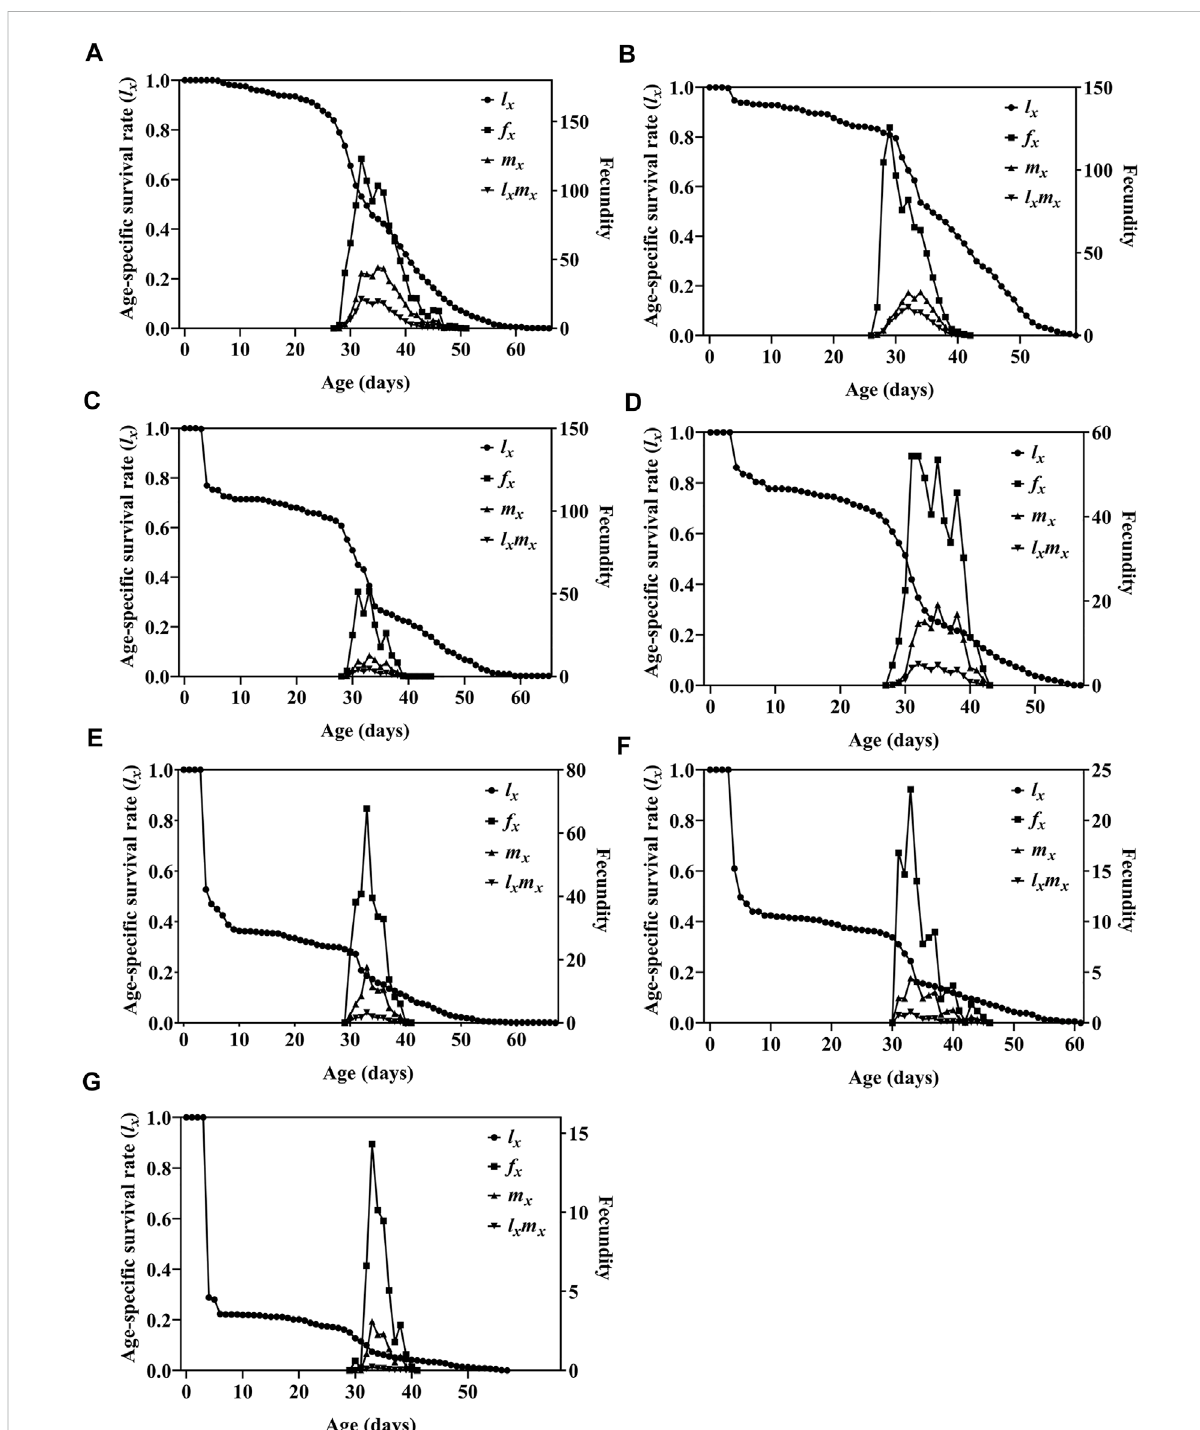
FIGURE 3 Age-speci fi c survival rate ( l x ), age-speci fi c fecundity of female adult ( f x ), age-speci fi c fecundity ( m x ), and age-speci fi c maternity ( l x m x ) of F 1 generation of Spodoptera litura after male parent was irradiated with different doses of X-rays. (A) Survival rate of F 1 generation of nonirradiated parents (N \ × N _ ). (B – G) F 1 generation after mating with nonirradiated females and males irradiated with 25 Gy, 50 Gy, 75 Gy, 100 Gy, 125 Gy, or 150 Gy doses of X-rays during pupal stage (N \ × T _ ) (N, nonirradiated; T, irradiation